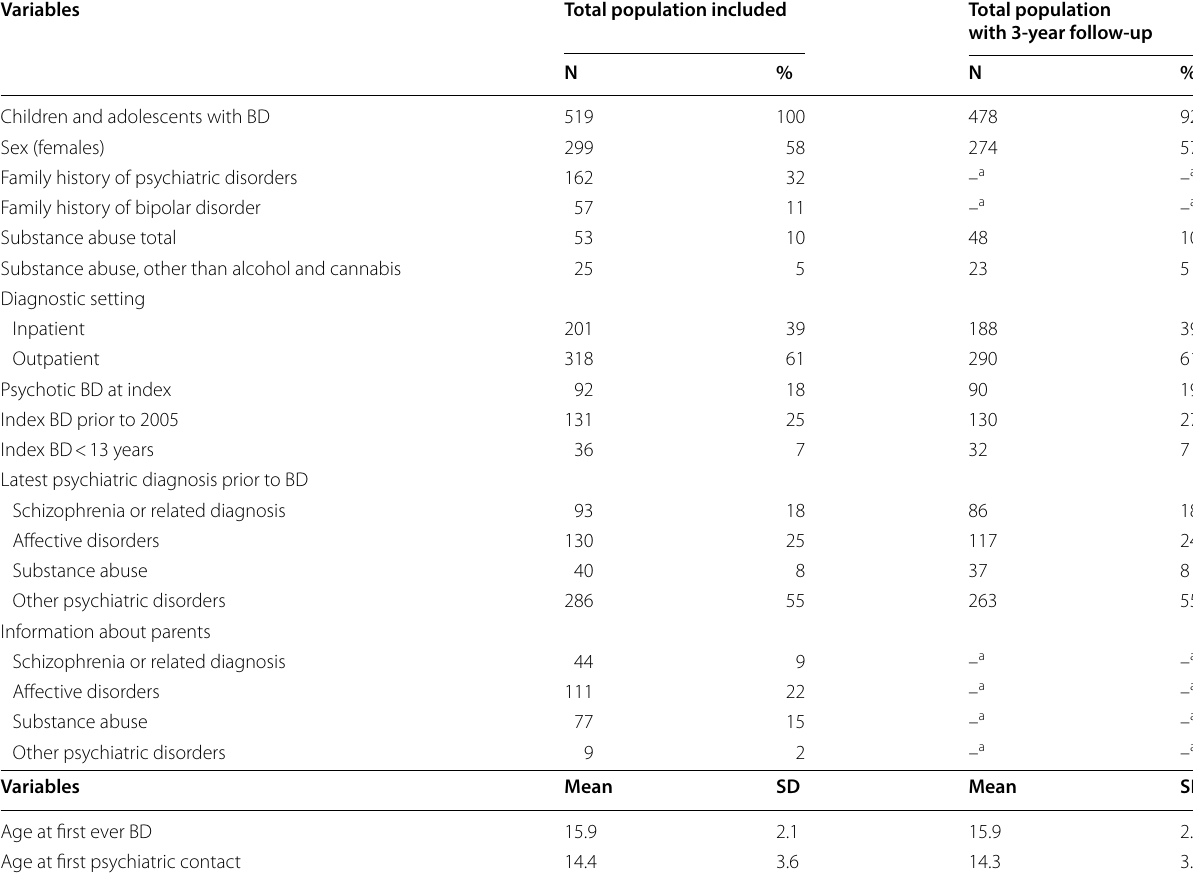
Table 1 Characteristics of bipolar disorder (BD) in children and adolescents between 1995 and